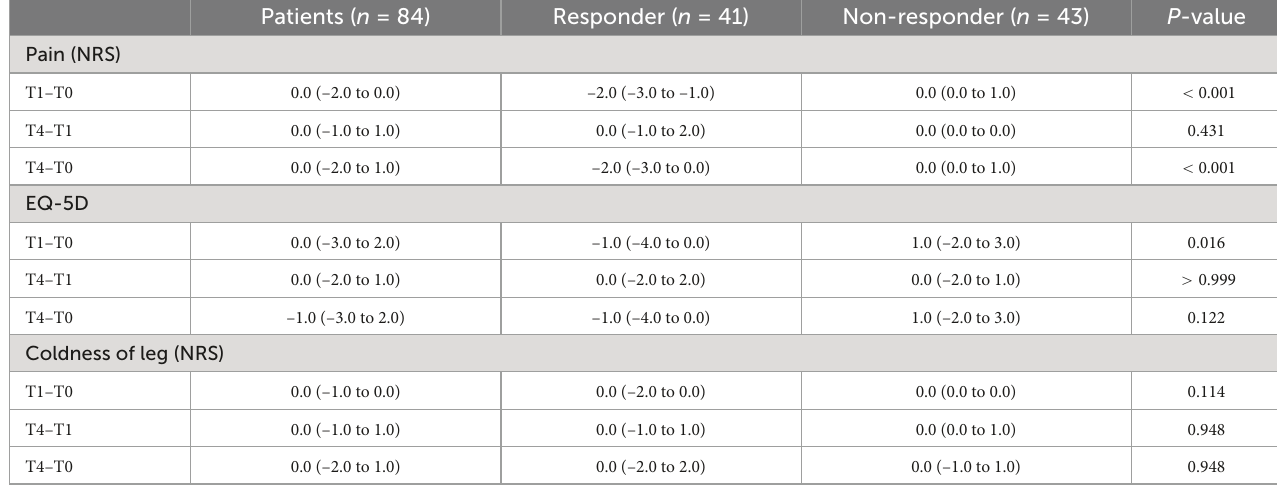
TABLE 5 Clinical outcomes over time between two